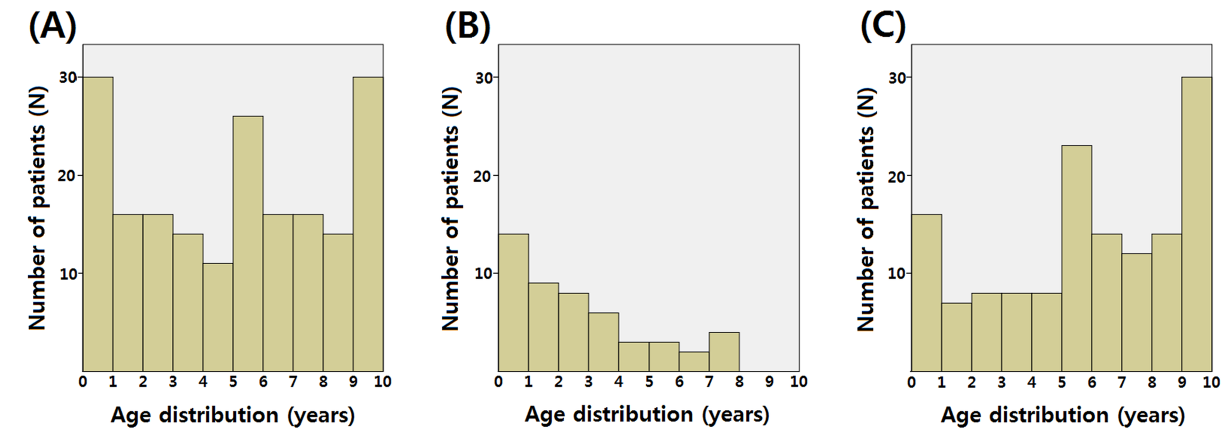
Fig 1. Age distribution of prepubertal epididymitis in all patients (A), in the known genitourinary anomaly group (B), and in the unknown genitourinary anomaly status group (C).